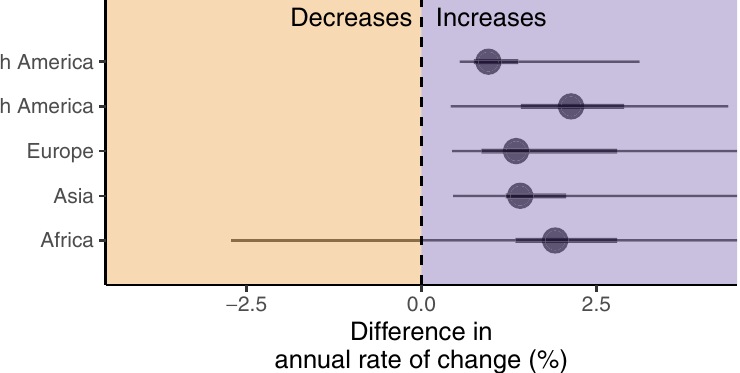
Fig.4|Humandevelopmentistheprimarydriverofpopulationchangeinlarge carnivores. Counterfactualscenariosdescribingthedifferenceintheannualrateof change (%) across the 1123 studied populations had there been no primary habitat loss ( a ),climate change( b ), or growth inhumandevelopment ( c ).Points fallingon the right of the dotted line indicate that the population would be predicted to increase had observed habitat loss, climate change, and human development